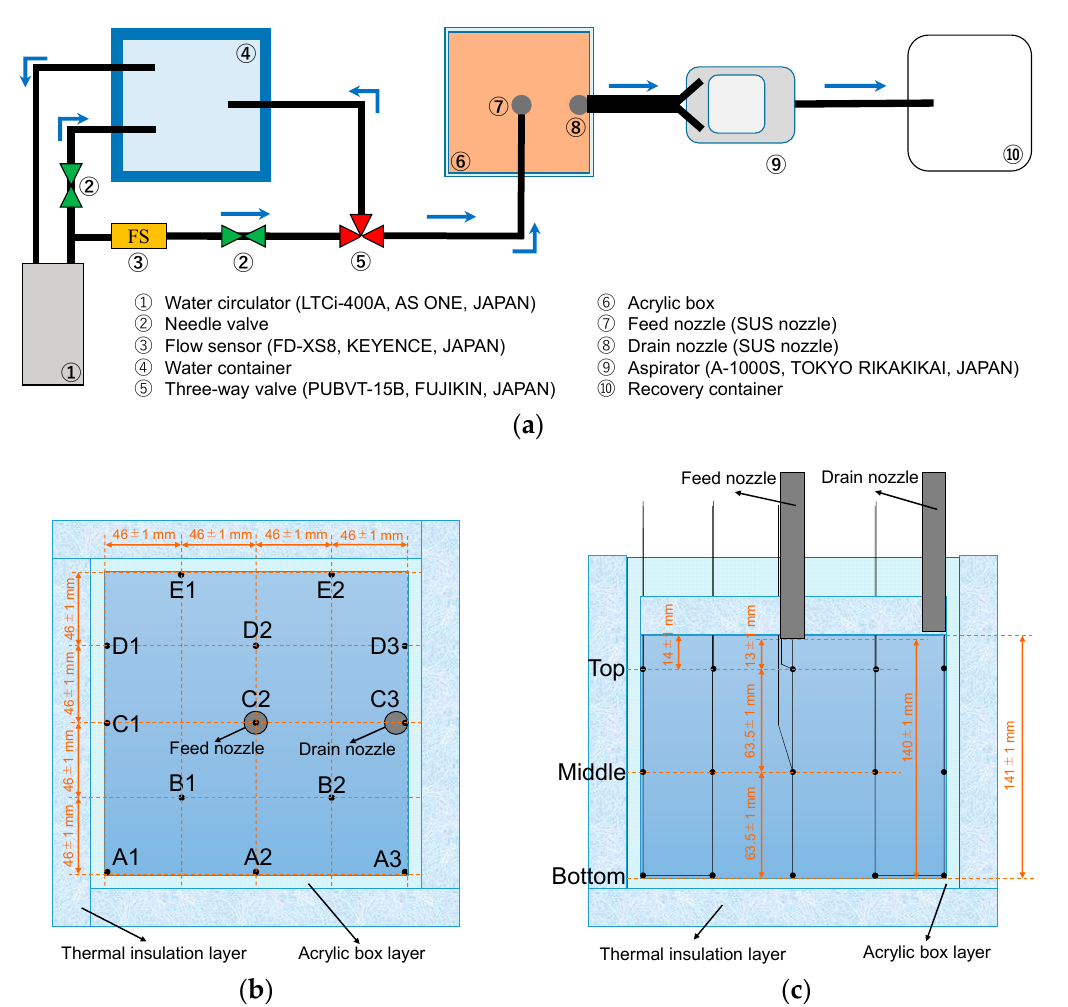
Figure 1. A schematic of the experimental setup for temperature data collection: ( a ) water circulation system; ( b ) vertical view of the acrylic box; ( c ) front view of the acrylic box.